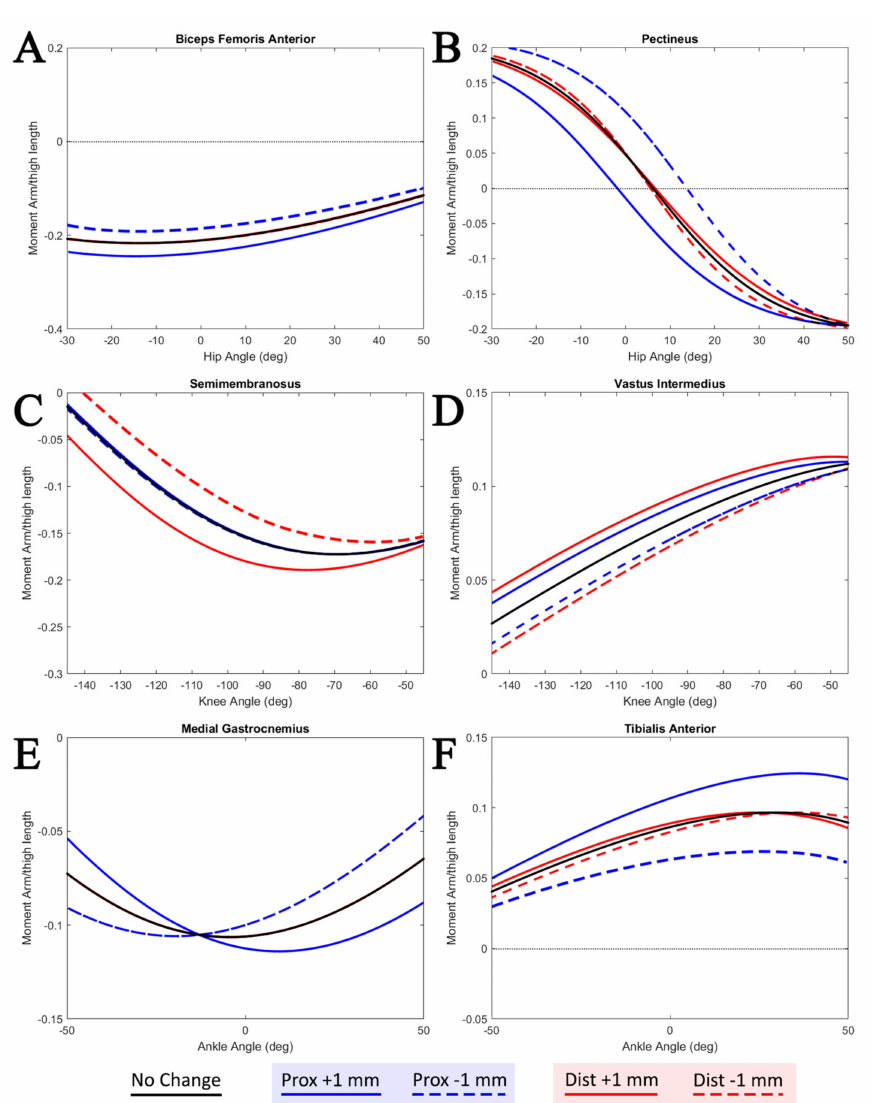
Figure 7. Sensitivity analysis of the moment arm profiles for muscles about ( A,B ) the hip, ( C,D ) knee, and ( E,F ) ankle. Proximal (prox) and distal (dist) attachment points for the free muscle segment are individually moved ± 1 mm, and the moment arm profile is calculated. Moment arm profiles are recorded under the same isolated joint motion presented in Figure 6. y -Axes are moment arm lengths normalized to the model’s femur